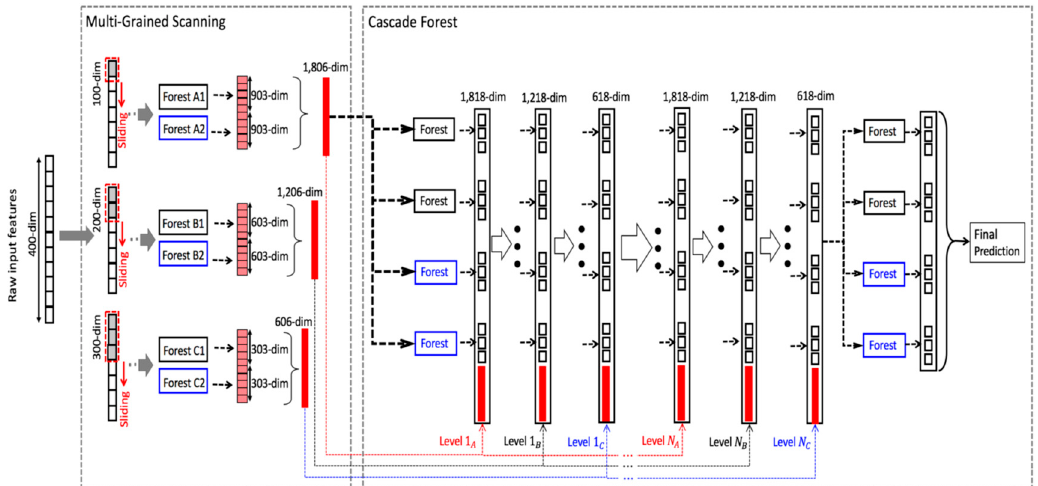
Figure 9. The overall structure of gcForest.